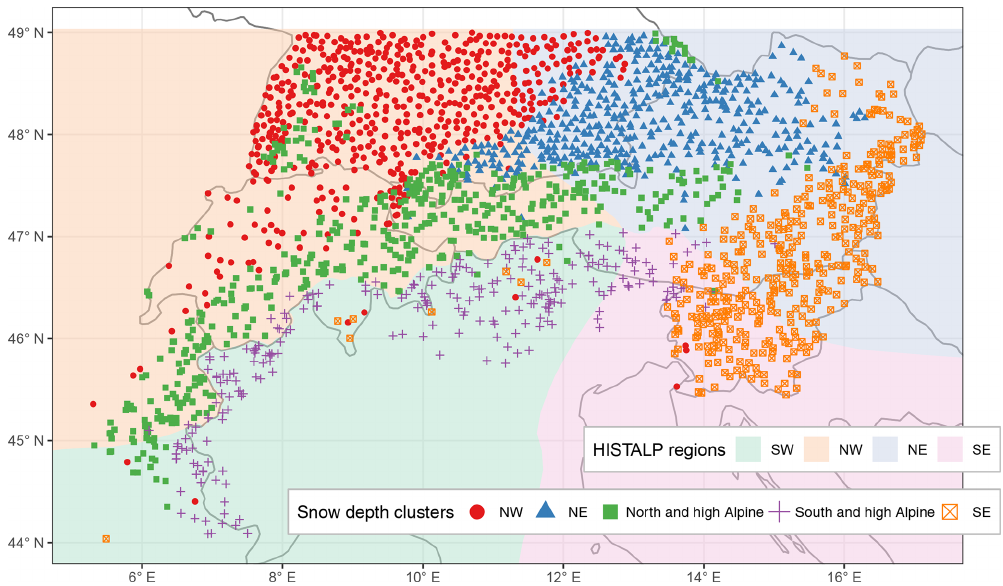
Figure 5. Clustering of stations based on daily snow depth data. Map of regions from applying a k -means clustering on the first five prin- cipal components. Underlaid are the HISTALP coarse-resolution subregions (Auer et al., 2007) which were derived using a semi-automatic principal component analysis of climate variables (temperature, precipitation, air pressure, sunshine, and